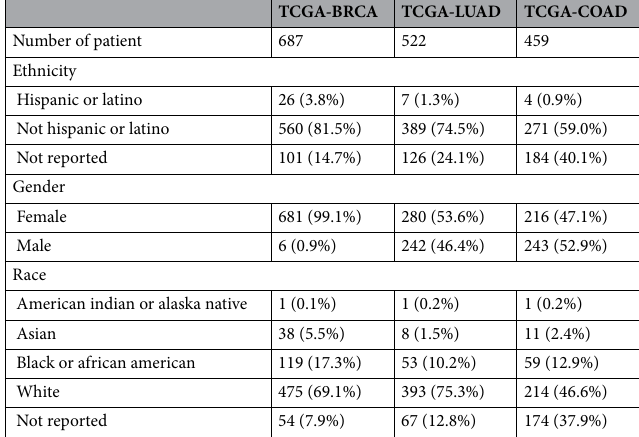
Table 1. Population characteristics. Patient information: ethnicity, gender and race.